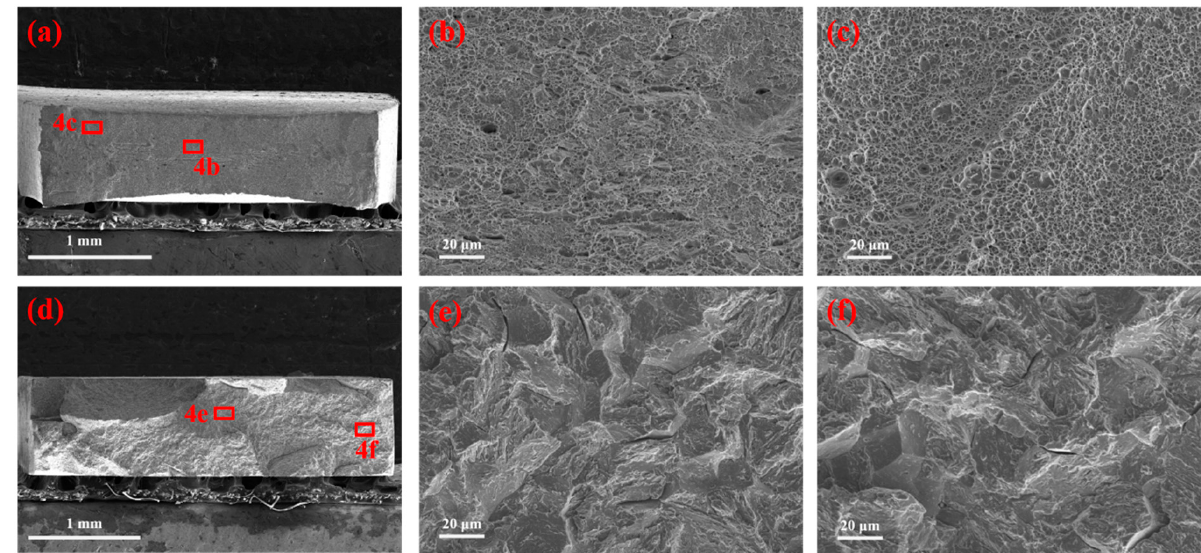
Figure 4. Fracture morphology of 22MnB5 steel tested at room temperature with and without hydrogen charging: ( a ) uncharged and ( b , c ) magnified region of red frame in ( a ), respectively; ( d ) hydrogen-charged and ( e , f ) magnified region of red frame in ( d ), respectively.